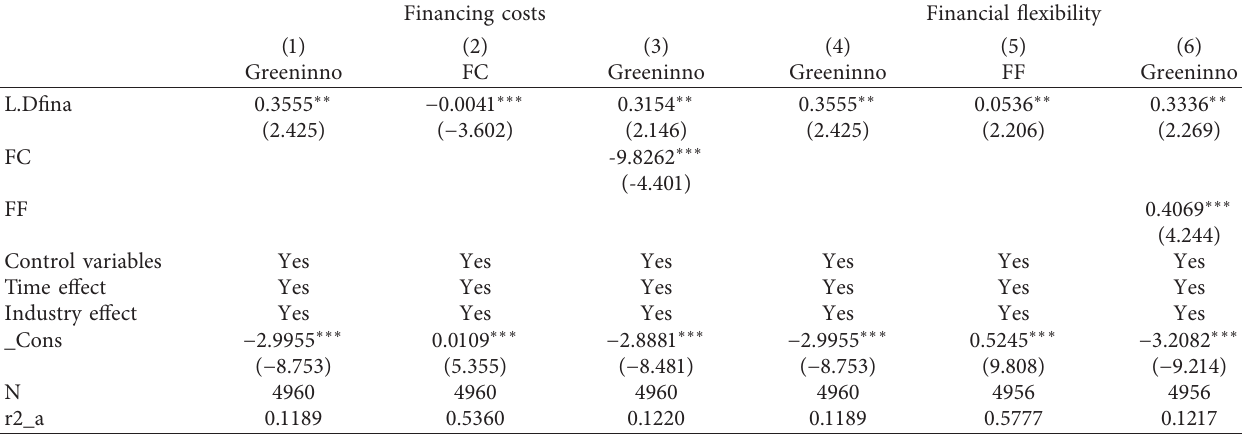
Table 6: The mediation effect test.